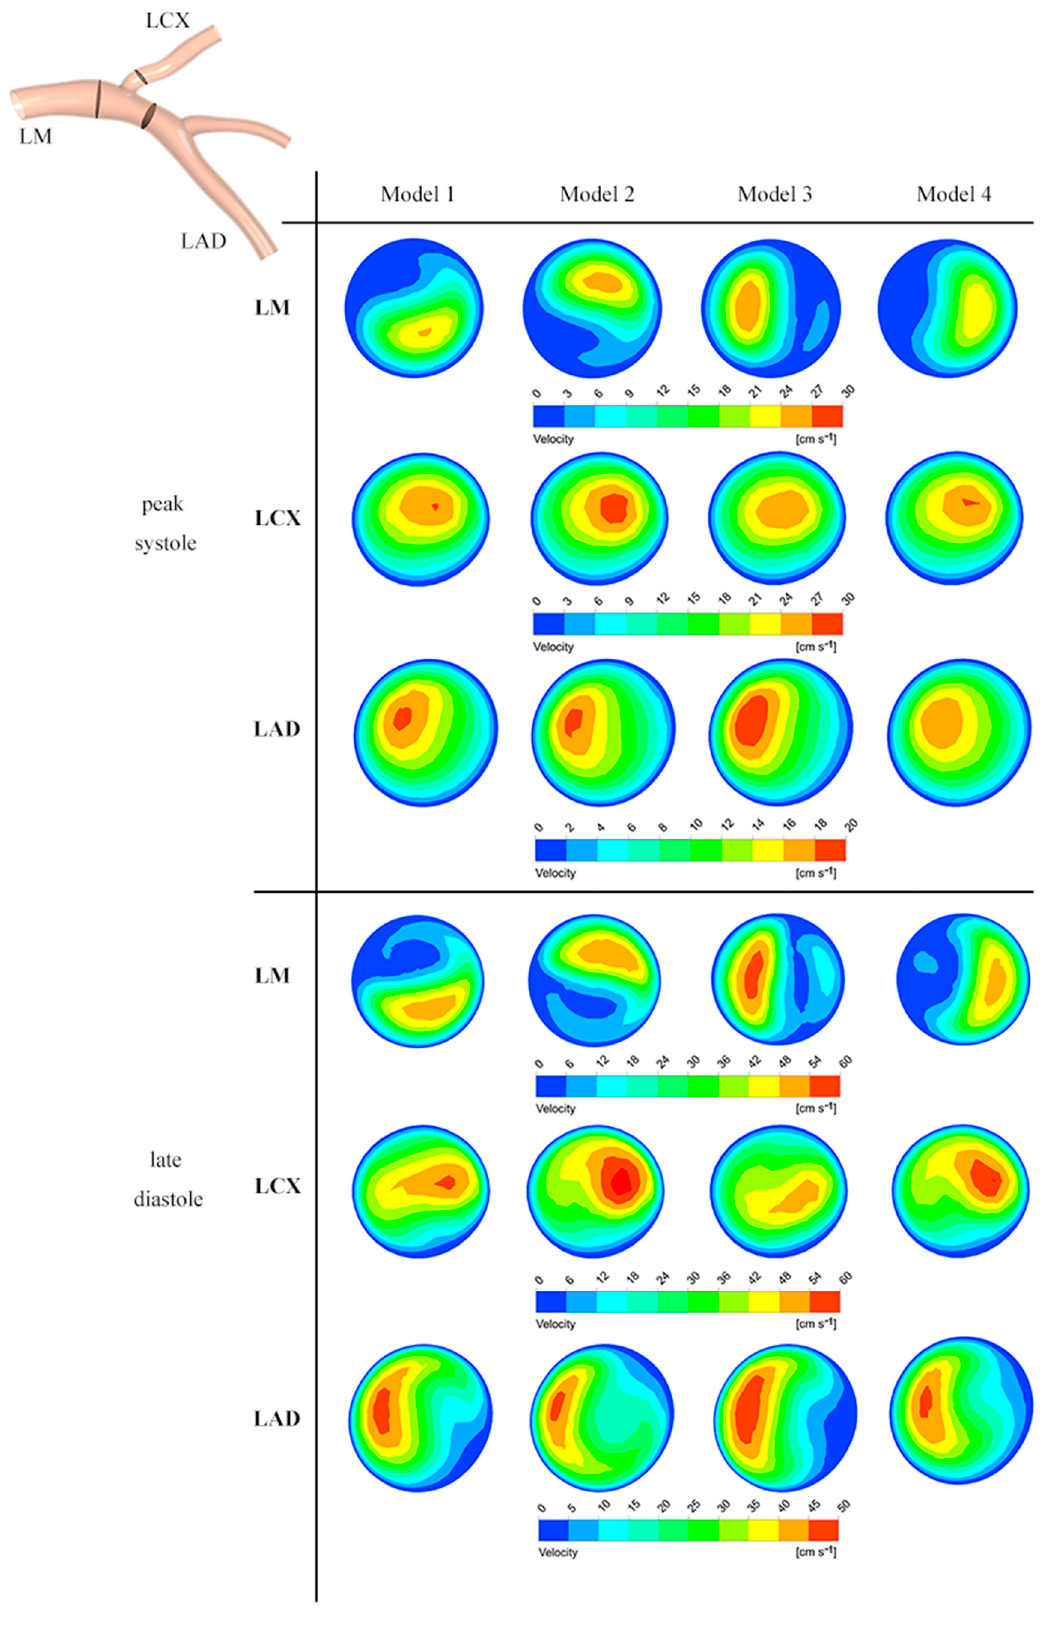
Figure 9. Velocity contours of each branch section during the peak systole and late diastole.